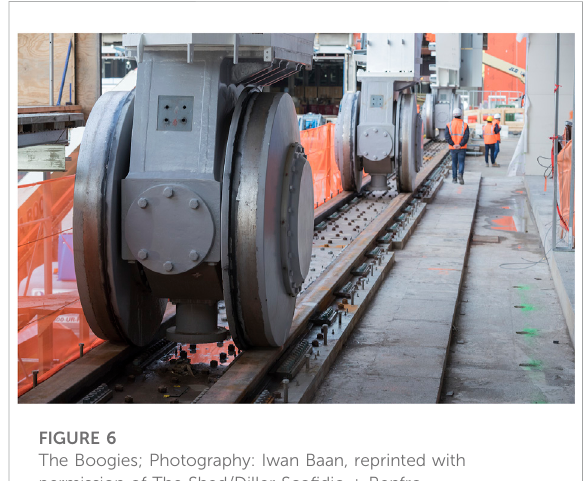
FIGURE 6 The Boogies; Photography: Iwan Baan, reprinted with permission of The Shed/Diller Sco fi dio +